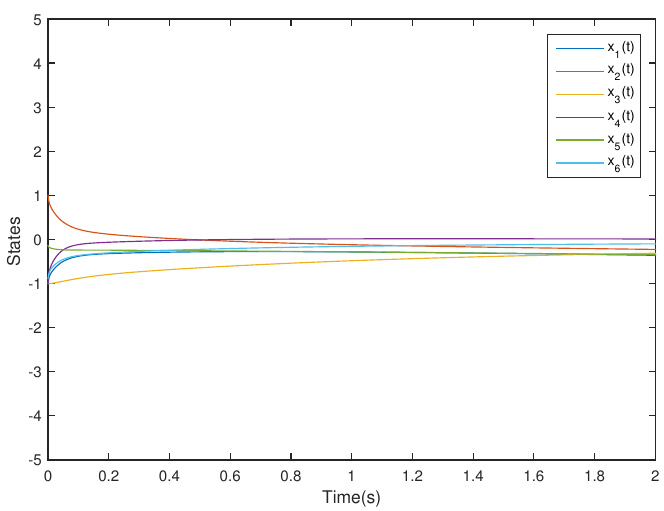
Figure 3. States responses of closed-loop system ( 31 ) in Example